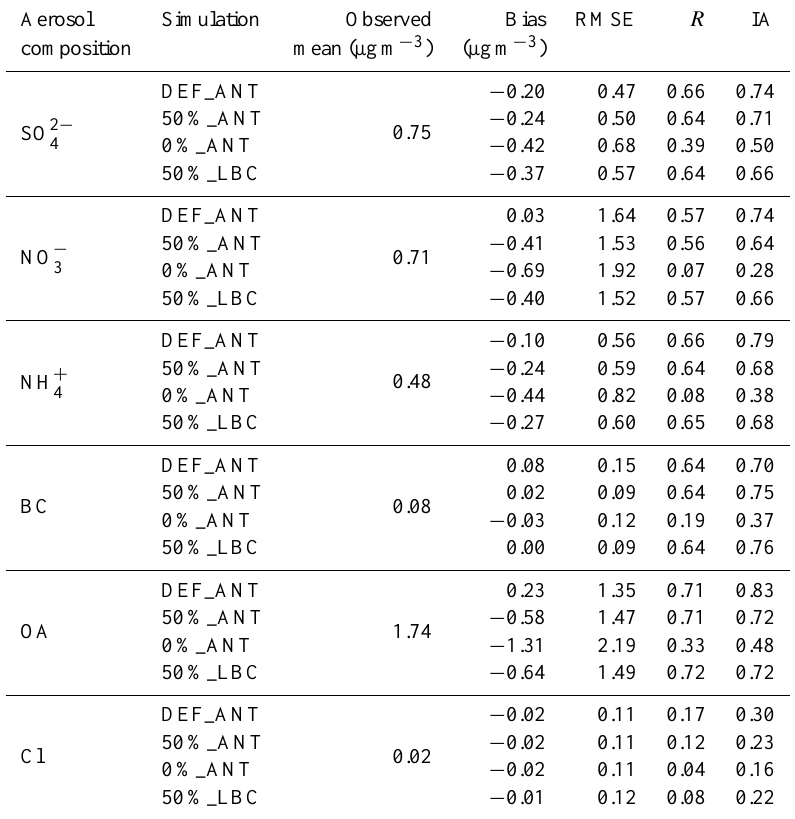
Table 12. Performance of simulated aerosol composition over all the WP-3D flights in terms of bias, root-mean-square error (RMSE), correlation coefficient ( R ), and index of agreement